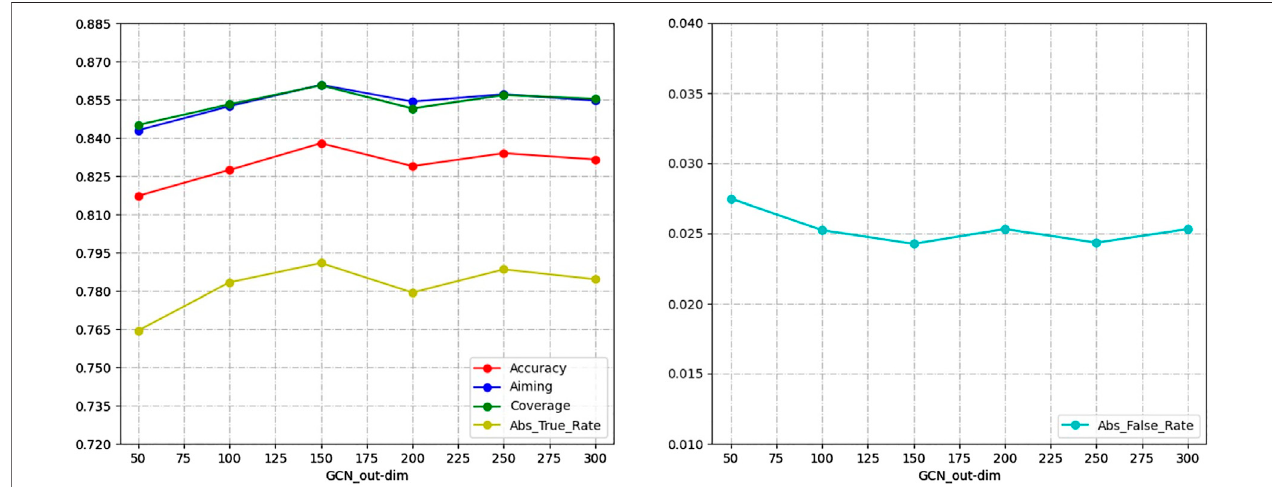
FIGURE 4 | GCN network Output dimension